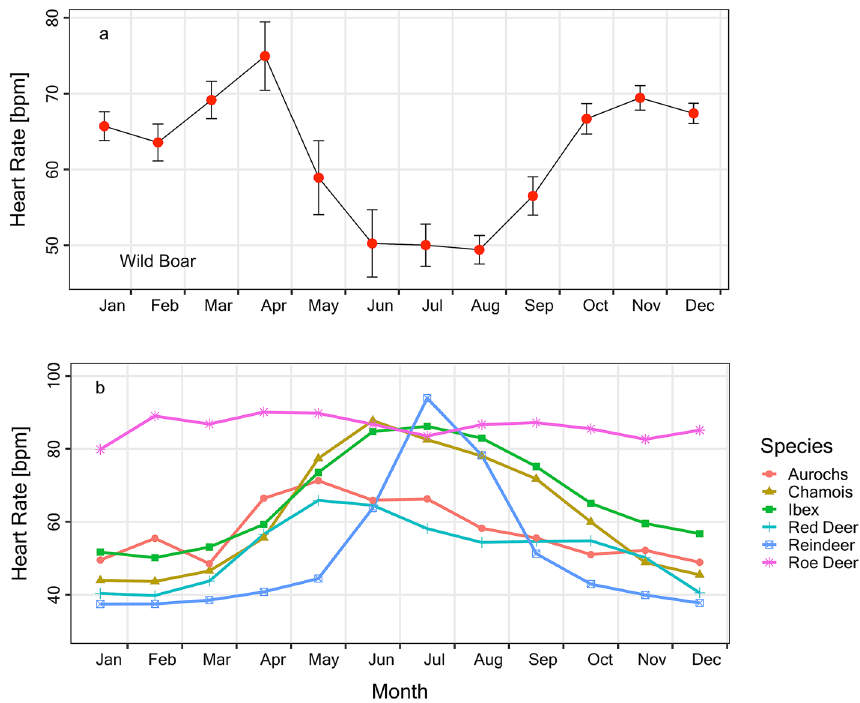
Figure 5. Seasonal time course of heart rate in northern ungulates. ( a ) Mean monthly HR ± SEM in wild boars (present study). ( b ) Traces of mean monthly HR in six species of ruminants. Data in ( b ) from Arnold 2